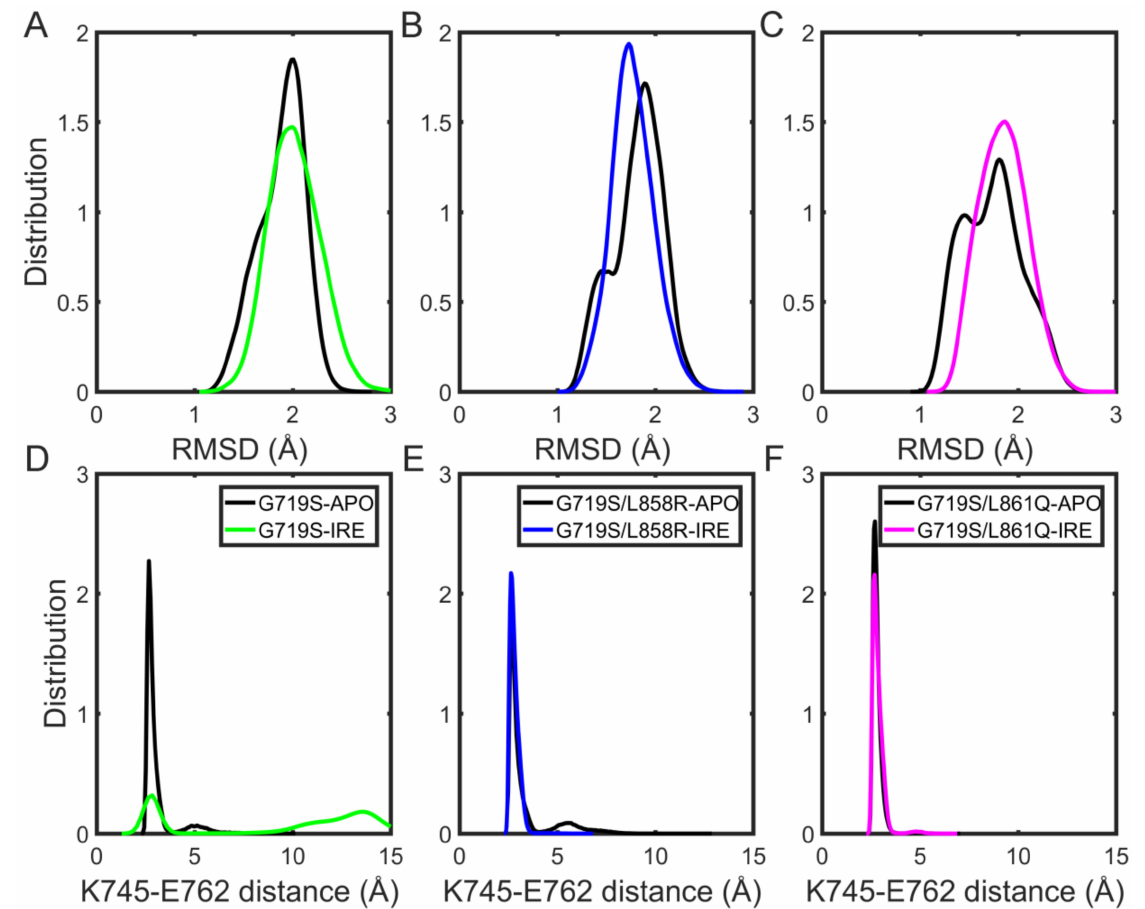
Figure 5. The stability of the α C-helix and KE salt bridge upon IRE binding during the simulations. The RMSD of the α C-helix backbone atoms in the absence and presence of IRE: ( A ) G719S mutants; ( B ) G719S/L858R mutants; ( C ) G719S/L861Q mutants. The probability distribution profiles of the distance between atoms K745/NZ and E762/(OE1, OE2) in the absence and presence of IRE: ( D ) G719S mutants with the APO form colored in black and with the complex form colored in green; ( E ) G719S/L858R mutants with the APO form colored in black and with the complex form colored in blue; ( F ) G719S/L861Q mutants with the APO form colored in black and with the complex form colored in